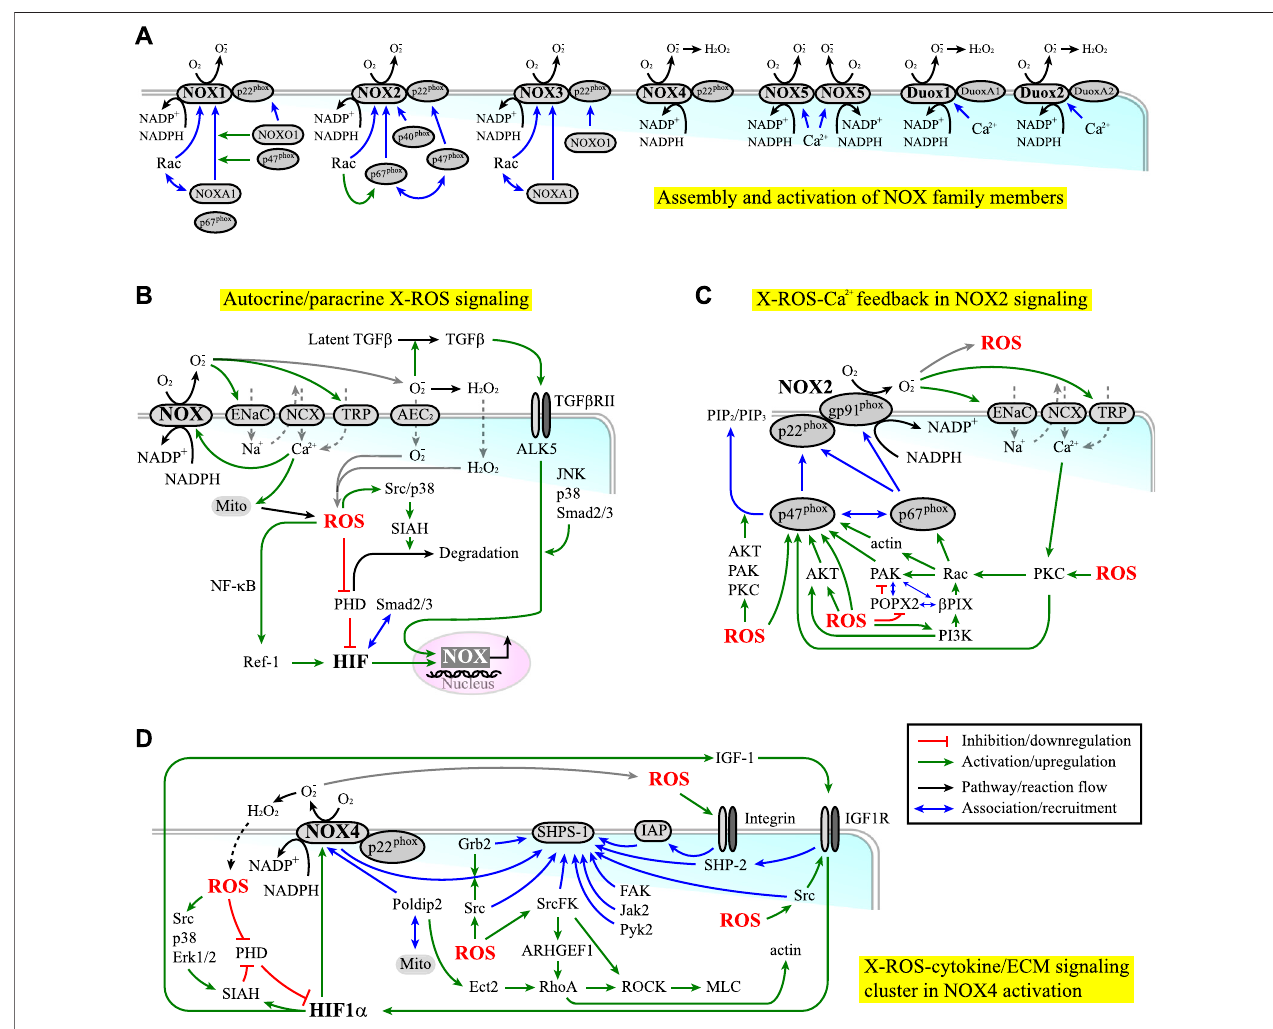
FIGURE3|(A) Theassembly(bluelines)and activation(green lines)ofNOXfamily members. (B) NOX-derivedROS(X-ROS)signalingcanelicitbothautocrineand paracrine effects. Red lines indicate inhibition or downregulation. Green lines indicate activation or upregulation. Blue lines indicate physical association or recruitment. Black lines indicate the fl ow of the pathways or a reaction. (C) NOX2 signaling is coupled with cytoskeleton dynamics and kinase/phosphatase activities through an X-ROS-Ca 2+ feedback loop. (D) NOX4 signaling is associated with the clustering of signaling molecules involved in the cytokine/integrin-ECM signaling.